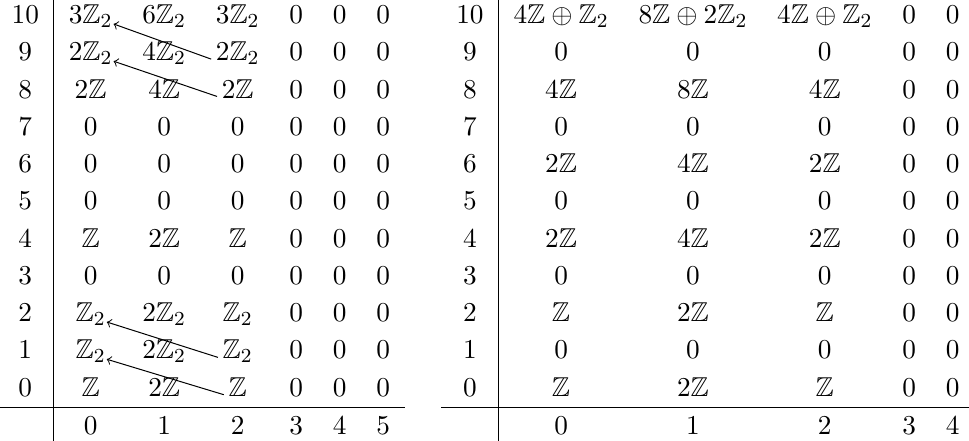
Table 8 . Second (and final) pages of AHSS for Ω Spin